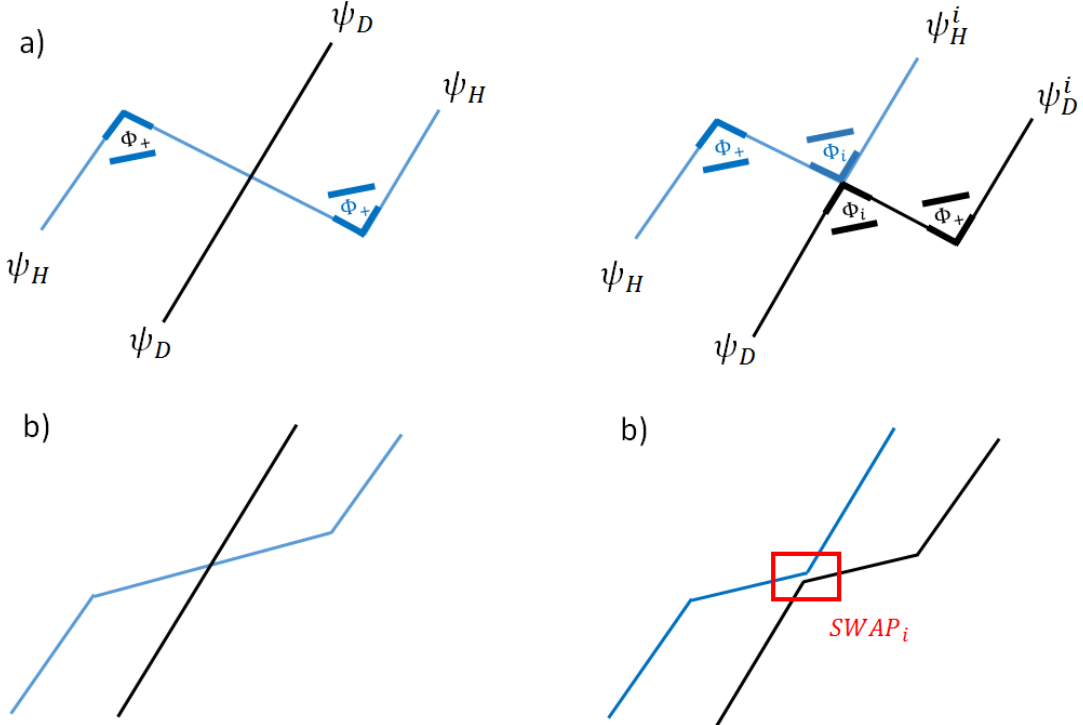
Figure 11 . The e(cid:11)ect of teleporting a state of a particle through \polyamorous" entanglement. a) three particle picture b) one particle